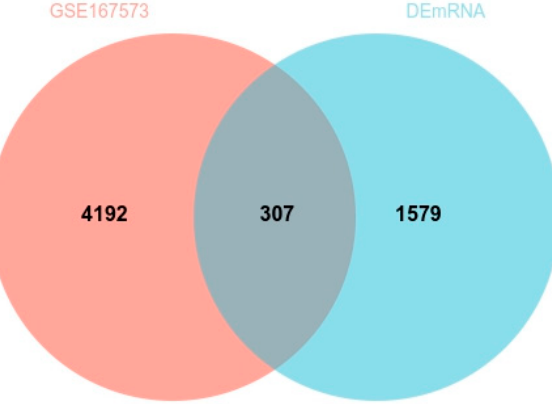
Figure 6. Venn plot of DEmRNAs of GSE167573 and this study.